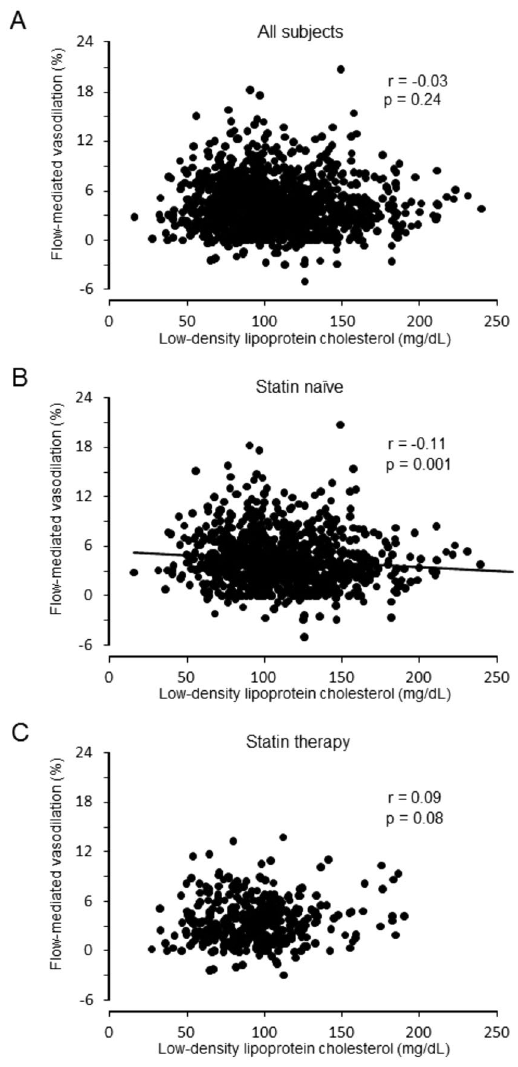
Figure 1. Scatter plots show the relationship between flow-mediated vasodilation and serum low-density lipoprotein cholesterol in all subjects ( A ), subjects not receiving statin therapy ( B ), and subjects receiving statin therapy ( C